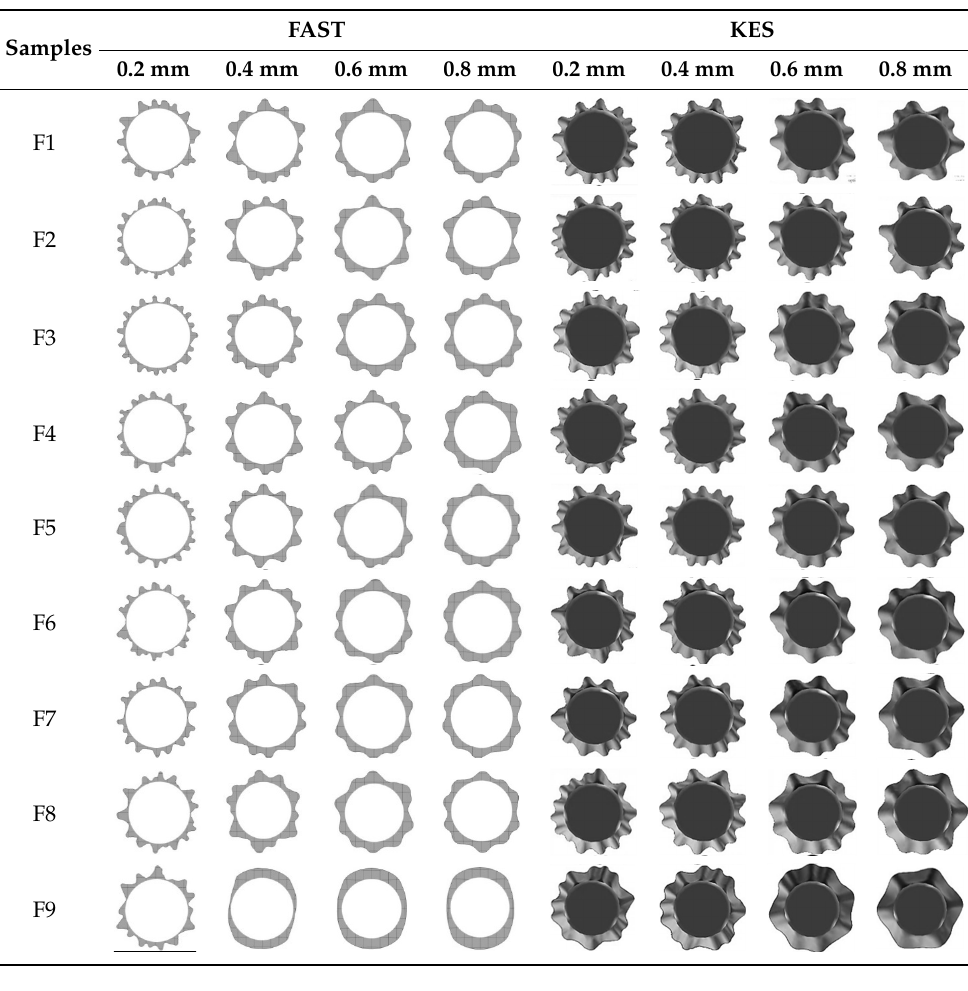
Table 4. Computer simulations of drape fabric samples with different polygonal mesh densities.